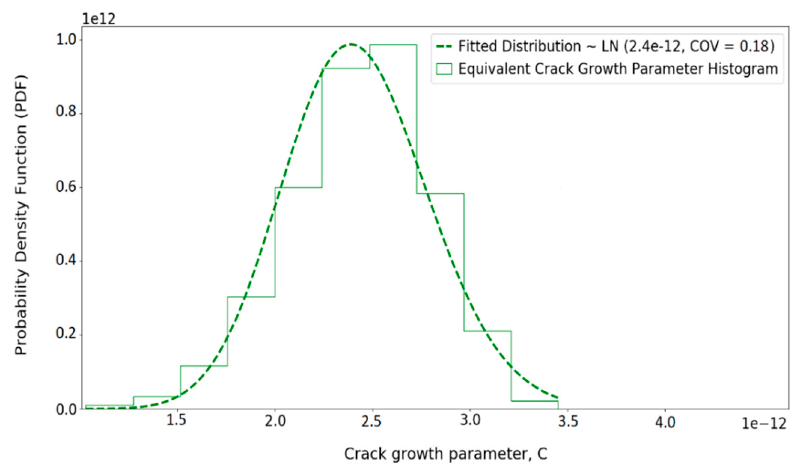
Figure 8. Equivalent crack growth parameter histogram and the fitted distribution.